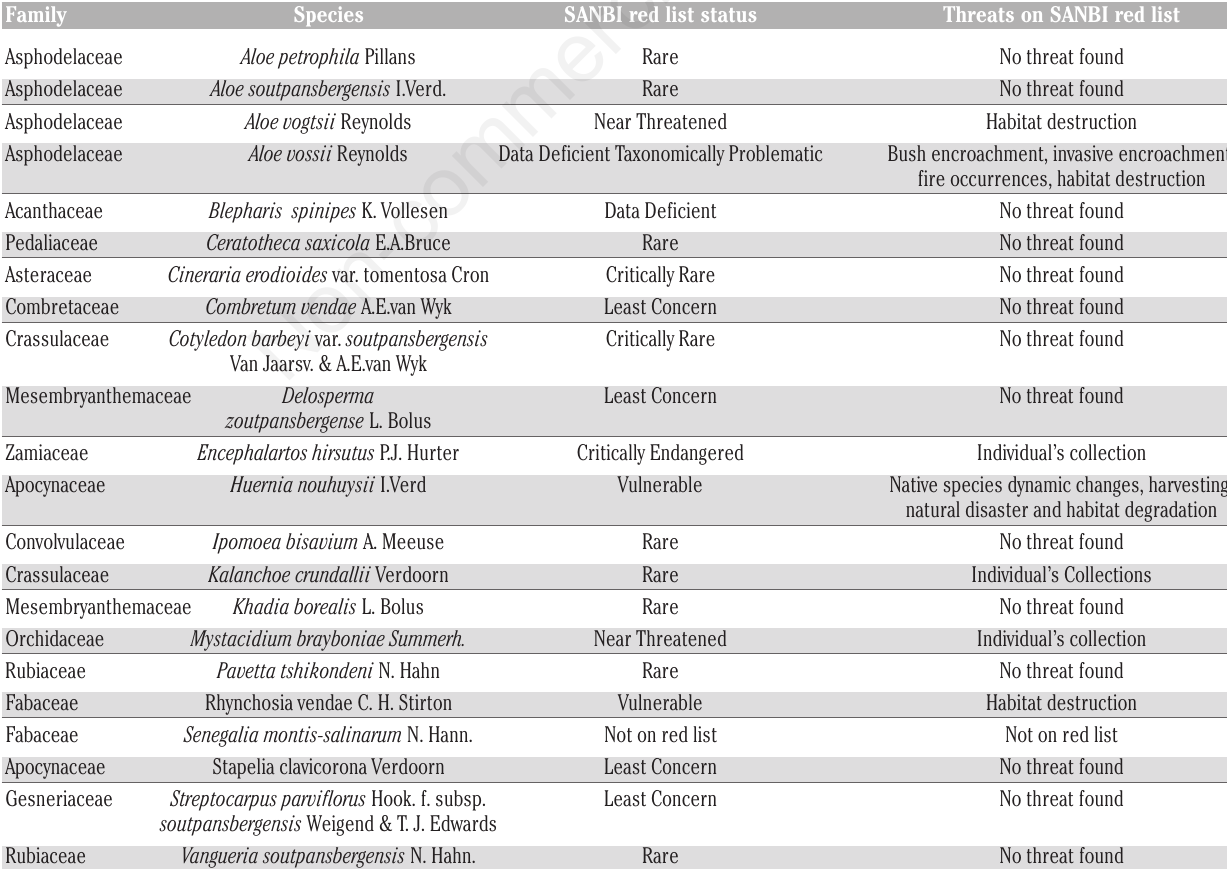
Table 1. List of vascular plant species endemic to Soutpansberg Mountain, their family, their SANBI red list status and their threats.